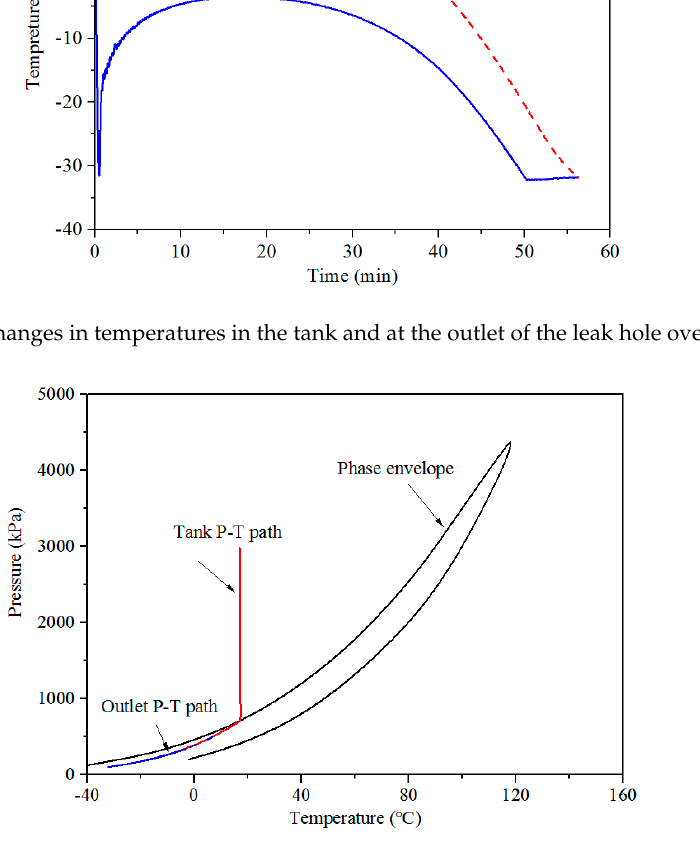
Figure 16. The NGL phase envelope and the P-T paths in the tank and at the outlet of the leak hole.